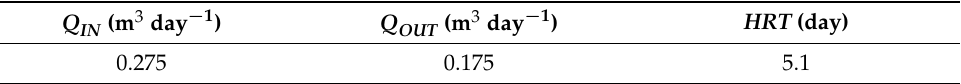
Table 1. Hydraulic Parameters Characterising the Phytoremediation Tank. Q IN is the Inlet Flow Rate, Q OUT is the Outlet Flow Rate, and HRT is the Hydraulic Retention